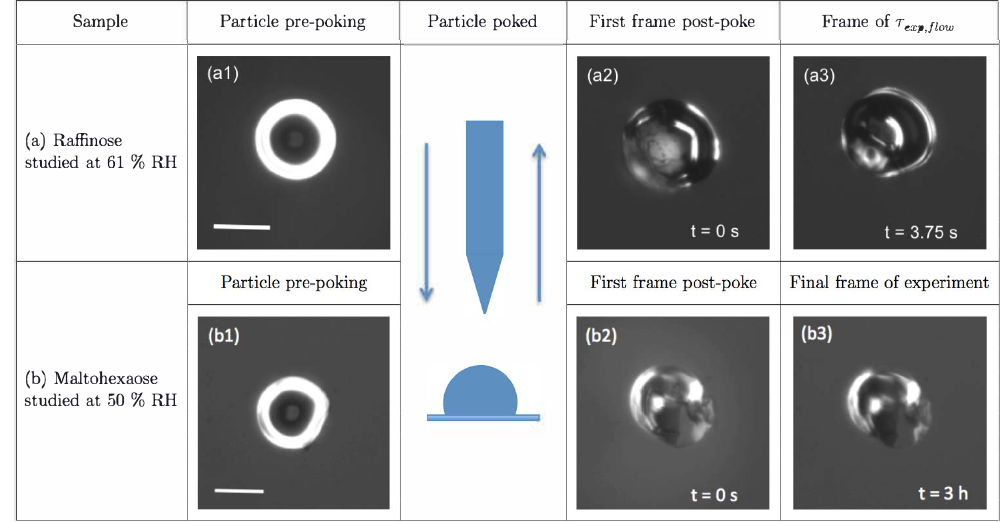
Figure 2. Optical images recorded during poke-and-flow experiments using particles of (a) raffinose–water and (b) maltohexaose–water mixtures. Panels (a1) and (b1) correspond to the particles prior to being poked, with the white haloes being an optical effect. Panels (a2) and (b2) correspond to the first frame after the needle has been removed. The particle comprised of raffinose and studied at 61% RH exhibited flow, and (a3) corresponds to an image of the particle at its experimental flow time, τ exp , flow , the point at which the diameter of the hole at the centre of the torus has decreased to 50% of its original size. The particle composed of maltohexaose and studied at 50% RH exhibited cracking behaviour and, as shown in (b3) , no change in the size or shape of the cracks can be observed 3h after the particle has been poked. The scale bars in (a1) and (b1) correspond to